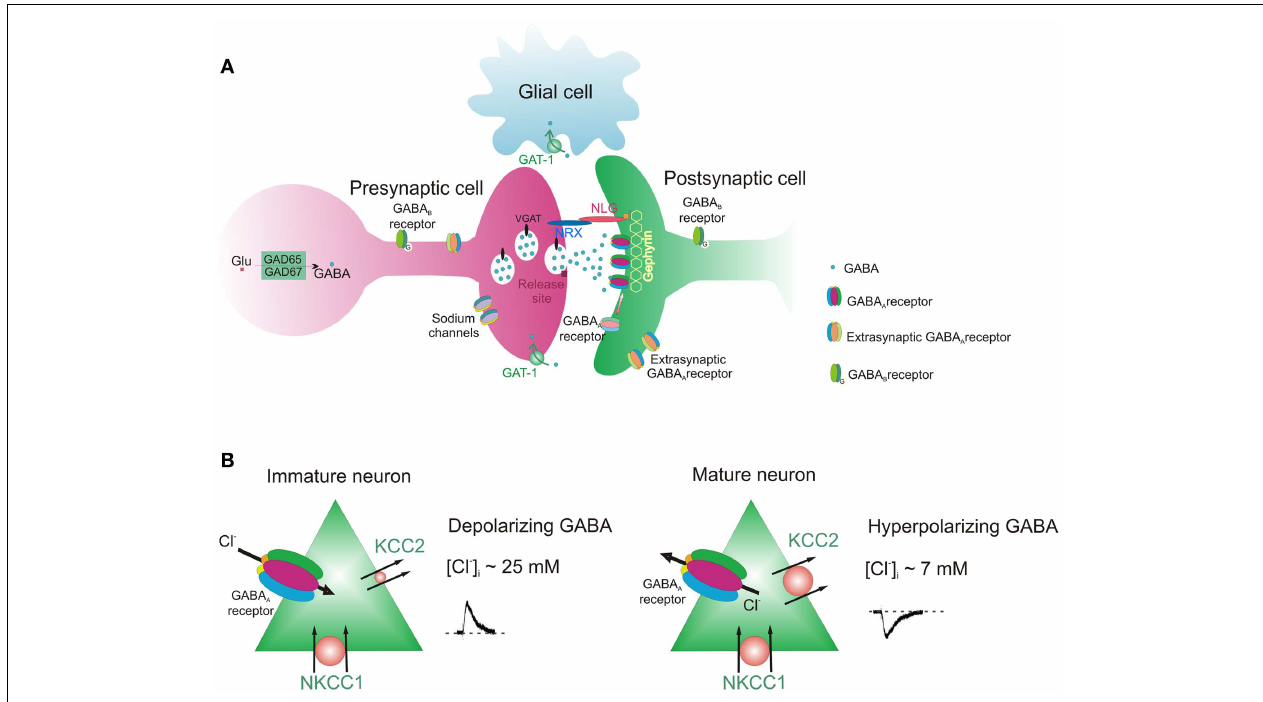
FIGURE 1 | GABAergic synapse . (A) Pre and post-synaptic sites of the synapse with different components whose functions can be altered in ASDs. (B) Direction of GABA action (depolarizing and hyperpolarizing) in immature and mature